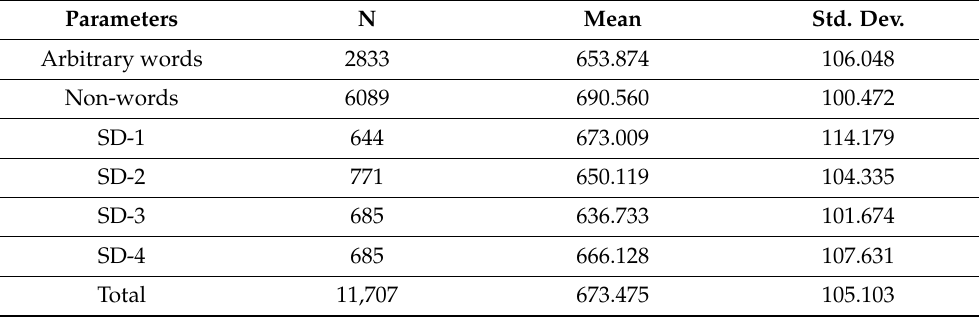
Table 6. Descriptive statistics for the Reaction Time to the Russian Stimuli Depending on Their Type.